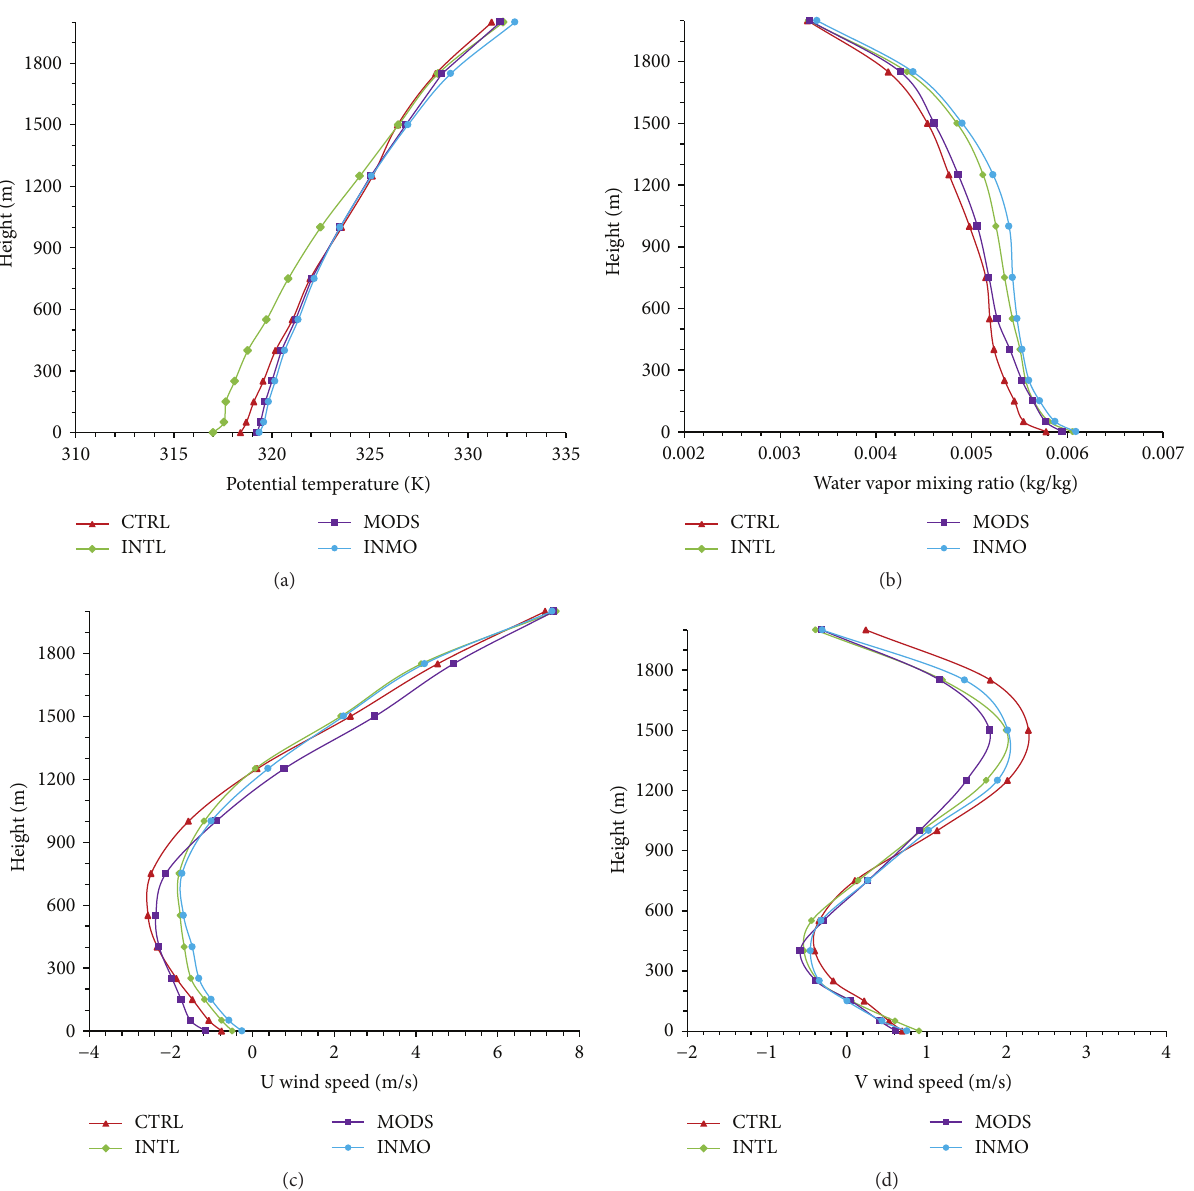
Figure 13: Average vertical profile of boundary layer at Arou station in June at 0:00: (a) potential temperature, (b) water vapor mixing ratio, (c) U wind speed, and (d) V wind